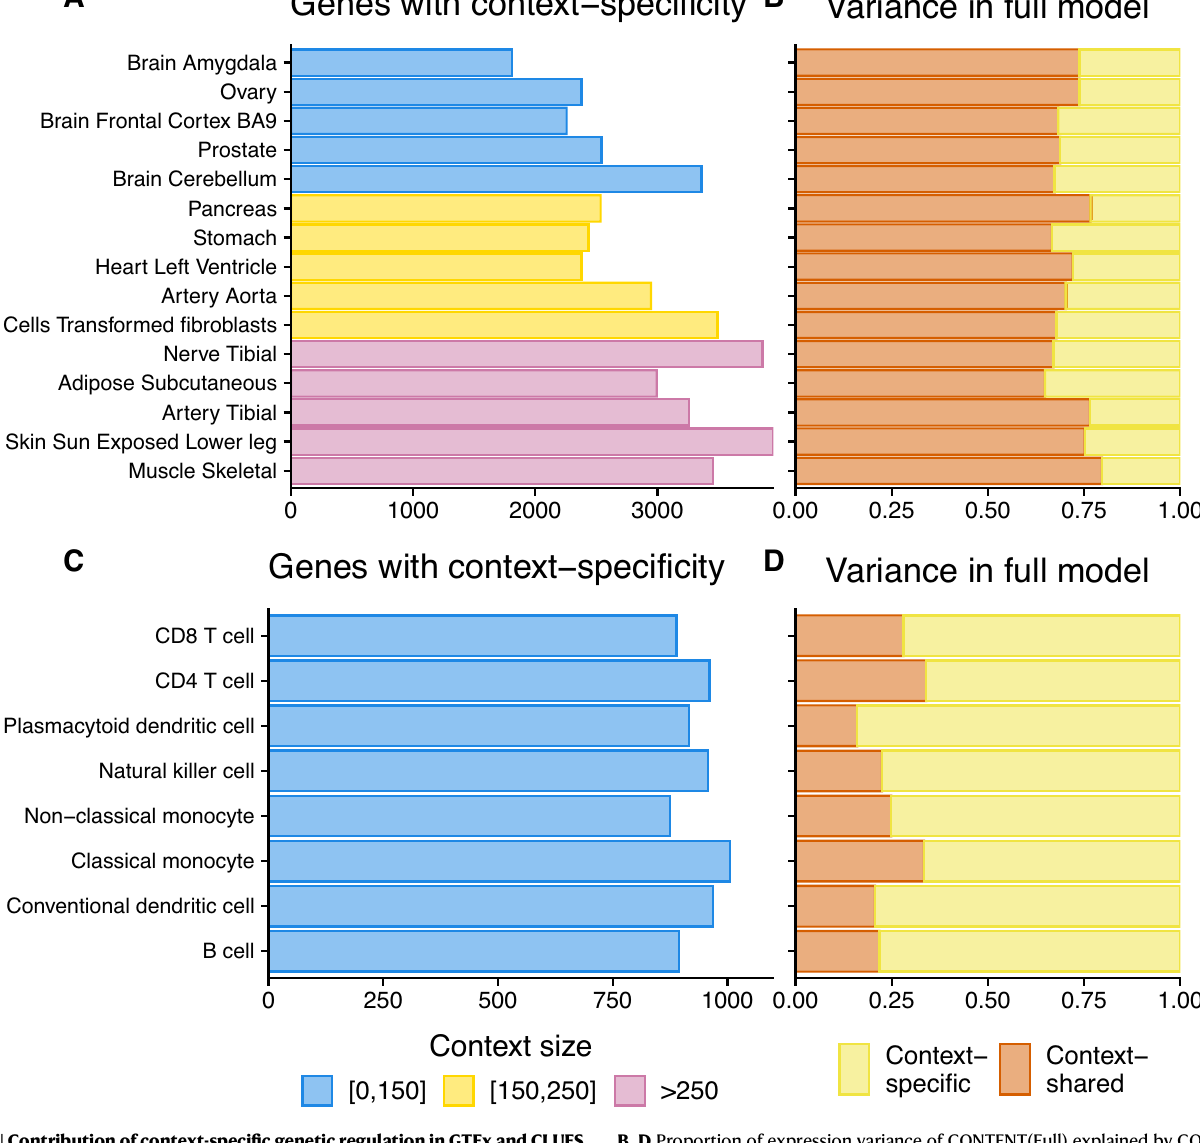
B , D Proportion of expression variance of CONTENT(Full) explained by CON- TENT(Speci fi c) and CONTENT(Shared) for genes with a signi fi cant CONTENT(Full)